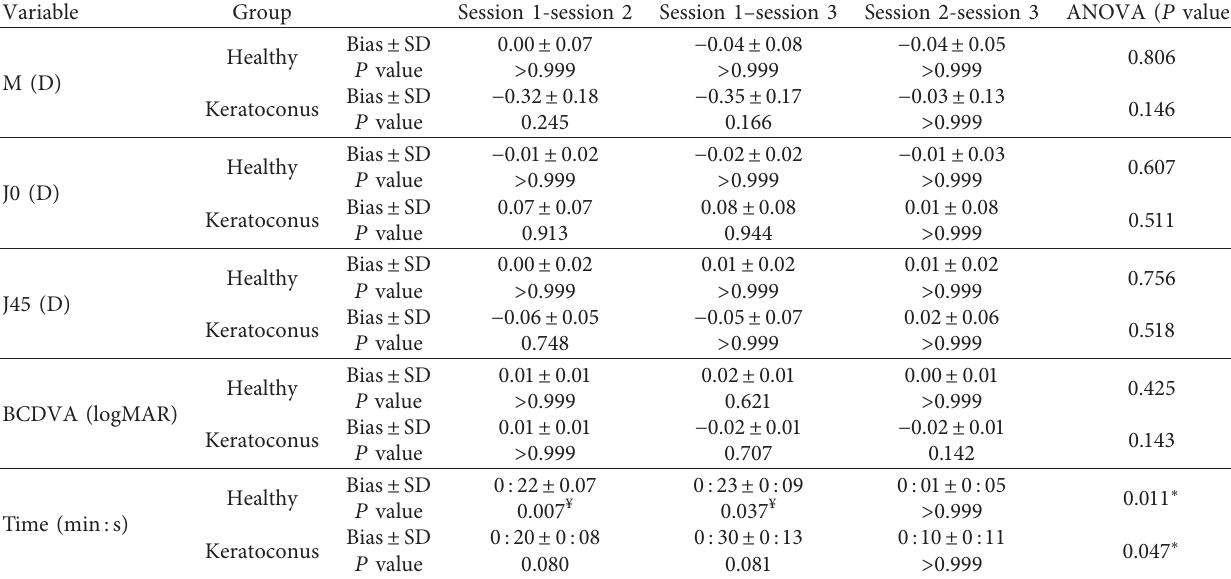
Table 4: Mean difference between sessions (bias) and its standard deviation (SD) for spherical equivalent (M), cylindrical vectors (J0 and J45), binocular corrected visual acuity (BCDVA), and spent time in refraction. Variable